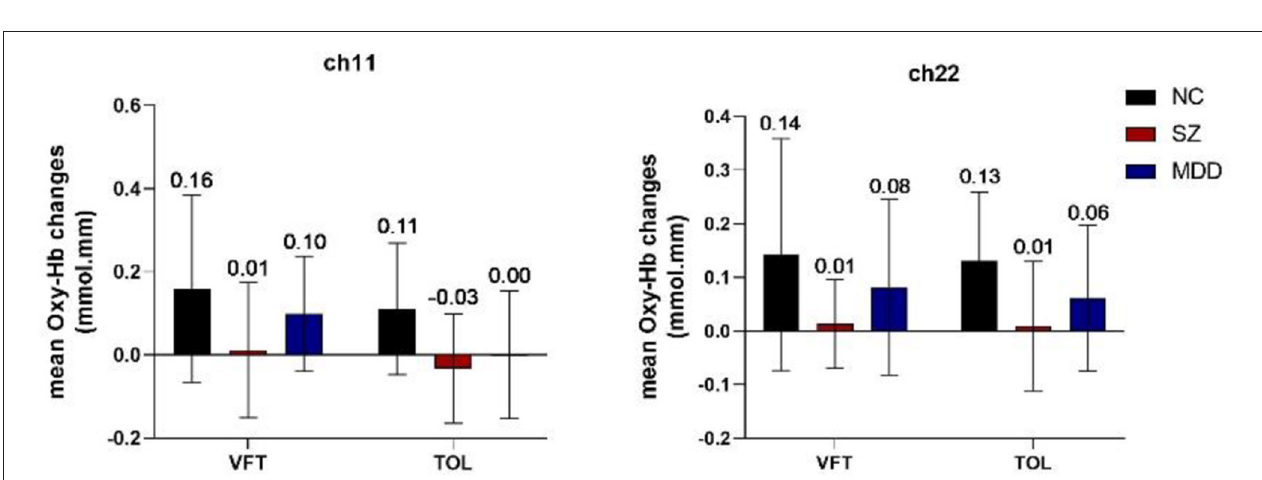
FIGURE 1 | PFC activation during the task. (A–C) respectively represents the PFC activation of SZ, MDD, HC in VFT; (D–F) respectively represents the PFC activation of SZ, MDD, HC in TOL.